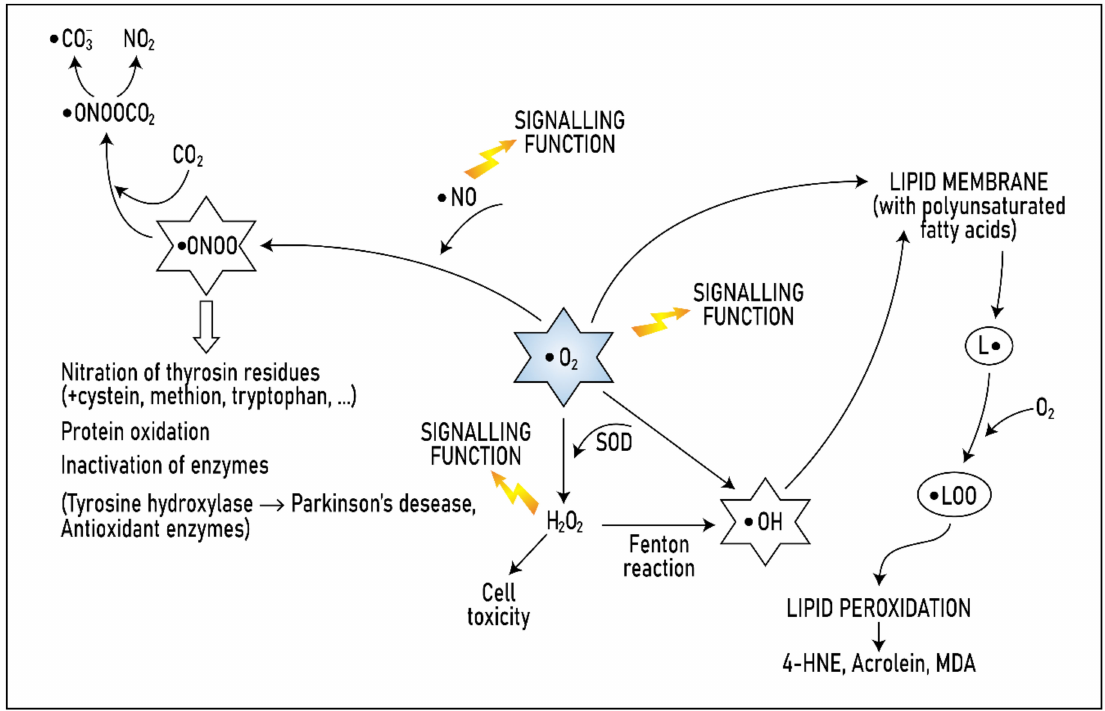
Figure 1. Role of superoxide in the formation of other radicals. Modified from